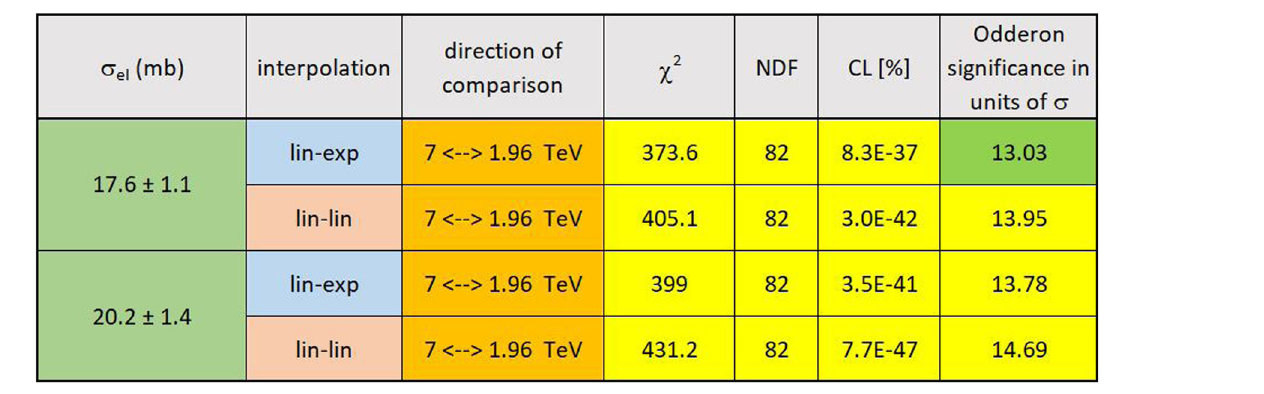
is found to be 0.01 σ , which means that the H ( x ) scaling functions